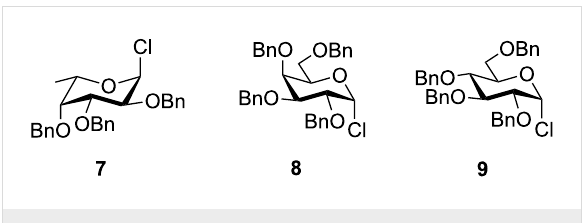
Figure 2: Benzylated glycopyranosyl halide donors 7 – 9